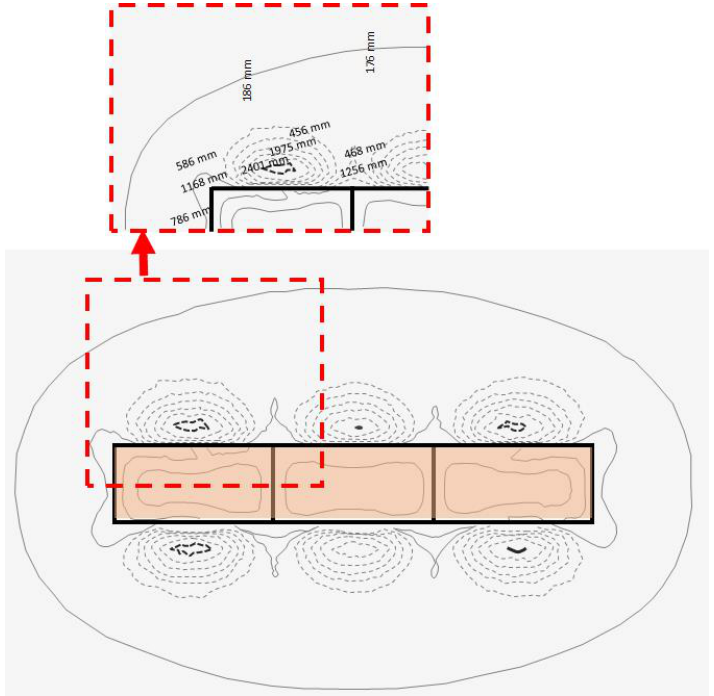
Figure 11. Contour lines showing the results of vertical soil settlement around the excavation pit.